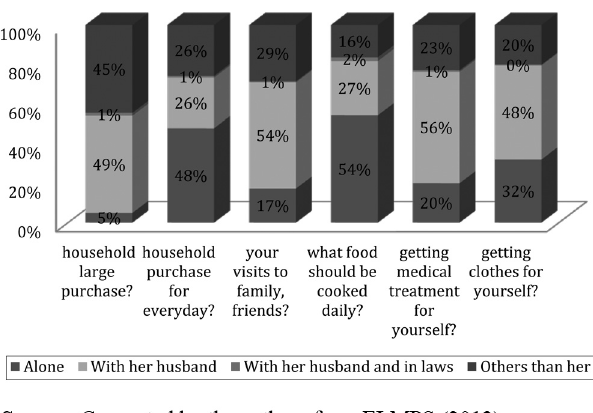
Figure 1. Distribution of answers for the decision-making questions